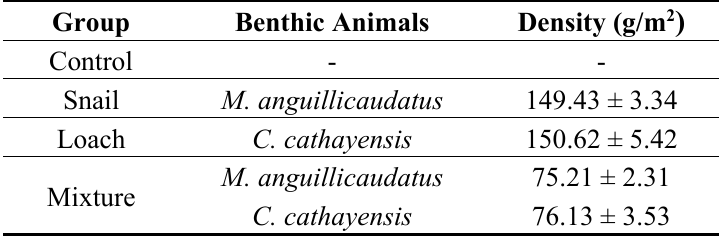
Table 2. Benthic animal addition in different